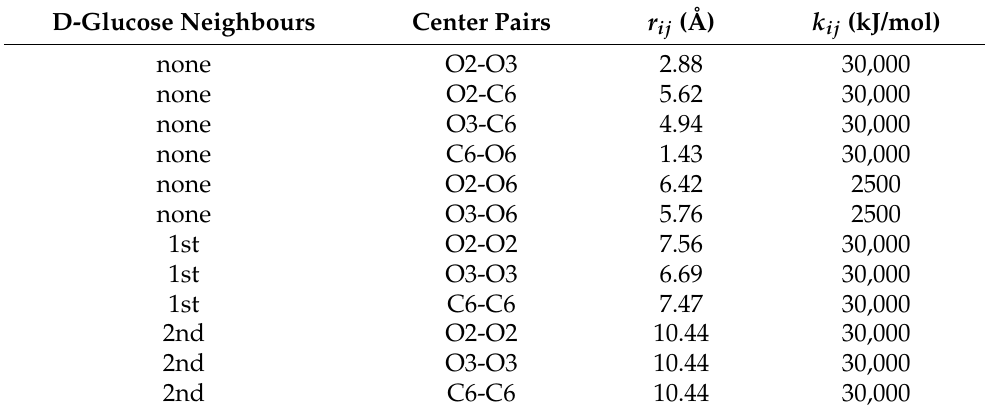
Figure 3. All-atom MD distribution of distances between atomic centers considered as CG sites. The labels assigned to distances are described in the method section, as well as the relationship between first and second D-glucose neighbours denoted by “+” and “++” respectively. Data for cellulose I α , I β and type-II are represented by purple, green, and yellow solid lines, respectively. The horizontal black line indicates the value of the optimal distance parameter in the CG model. The distributions are bell-shaped with the exceptions of the intra-glucose distances O2-O6 and O3-O6, which follow a bimodal distribution. Table 1. Optimal CG bonded parameters for cellulose I allomorphs and type-II fibrils. Parameters are defined within a D-glucose and between the two subsequent